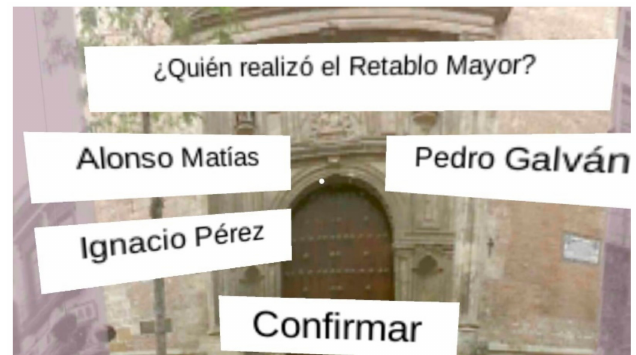
Figure 4. An example of the questions which appear in the program.